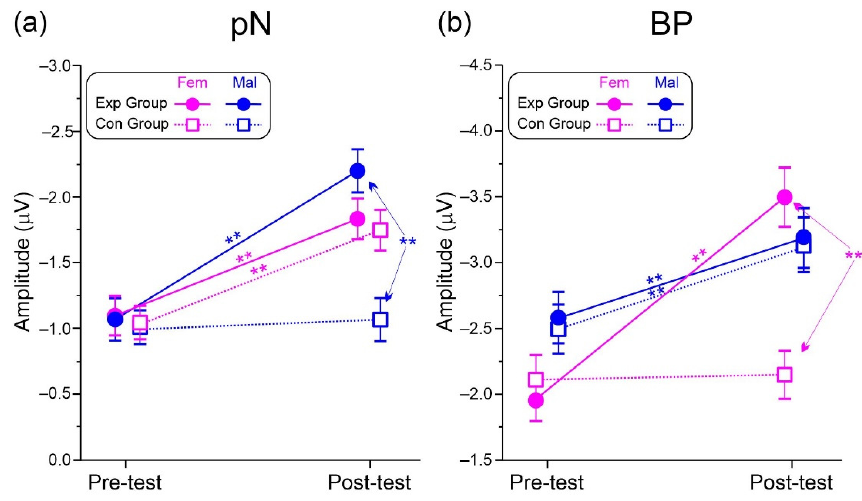
Figure 6. Significant 3 ‐ way interaction. ( a ) pN component. ( b ) BP component. Vertical bars denote